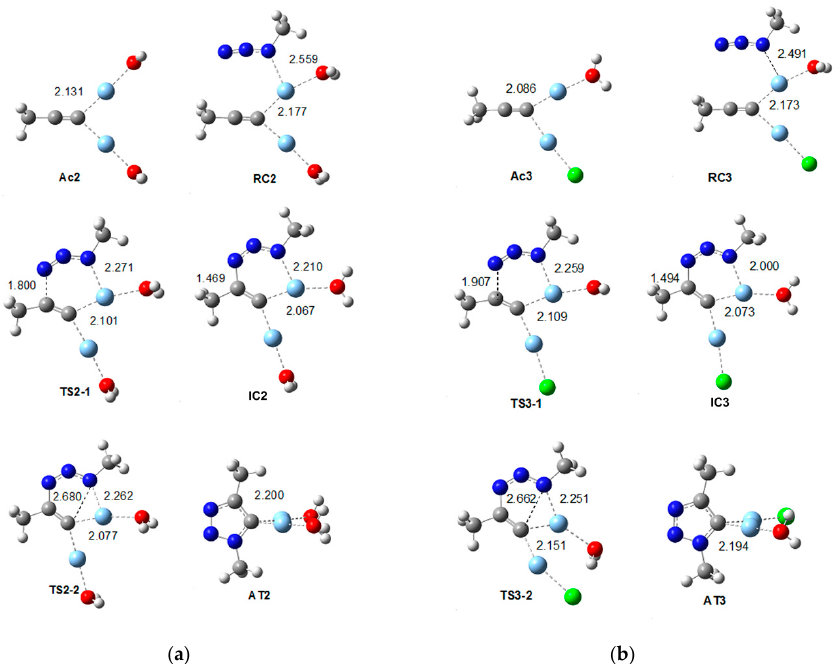
Figure 10. Optimized geometries (in water) of the stationary points involved in the dinuclear AgAAC reaction of ( a ) Ac2 and ( b ) Ac3 with 5 . Distances are given in Å.